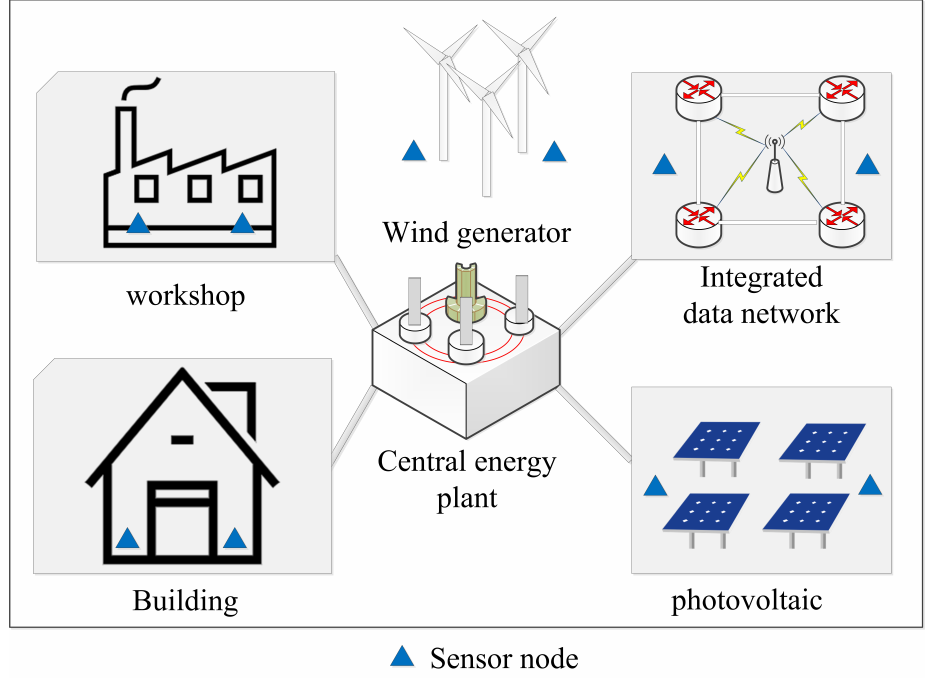
Figure 1. A microgrids state detection system based on